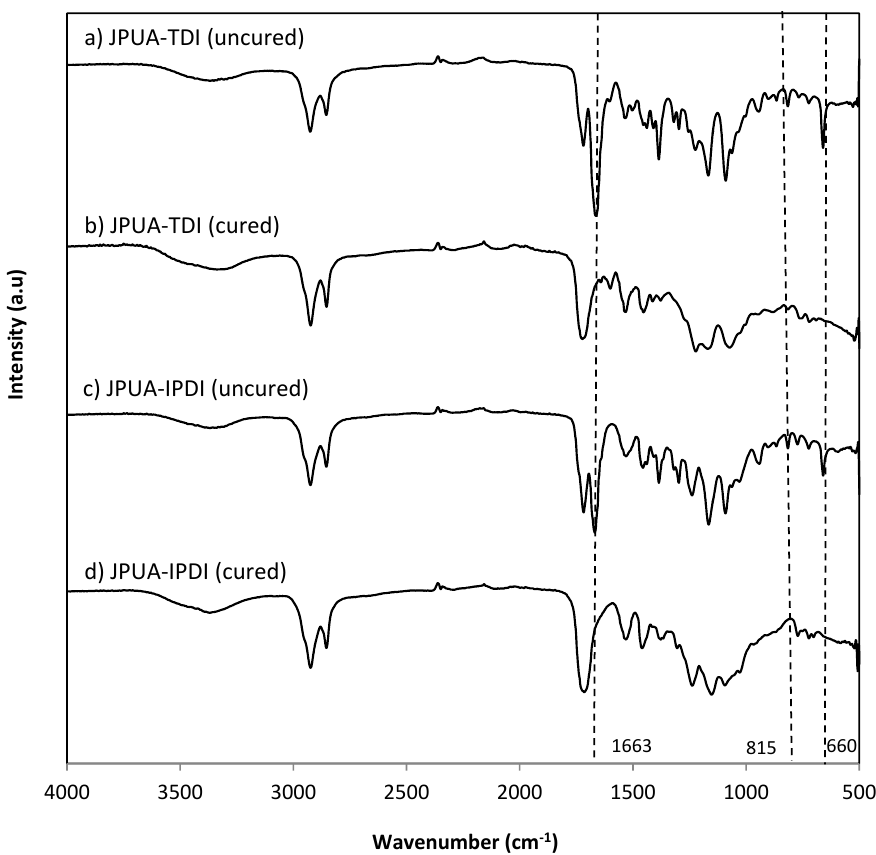
Figure 6. FTIR curves of JPUA-TDI and JPUA-IPDI before and after UV irradiation respectively.